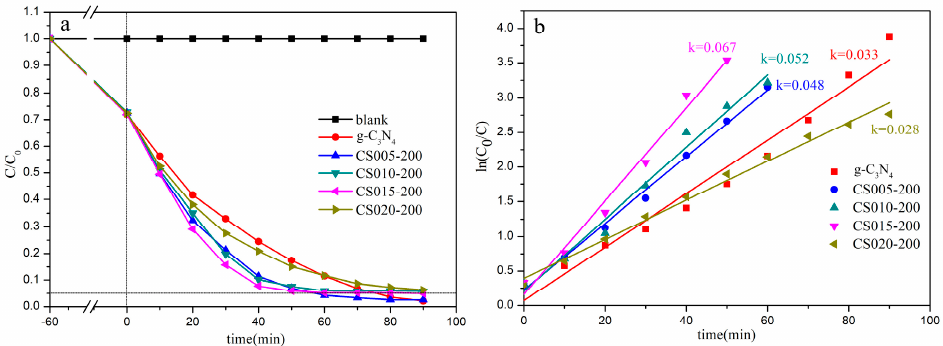
Figure 8. Photocatalytic activities ( a ) and their kinetic constants ( b ) of g-C 3 N 4 , CS005-200, CS010-200, CS015-200, CS020-200.